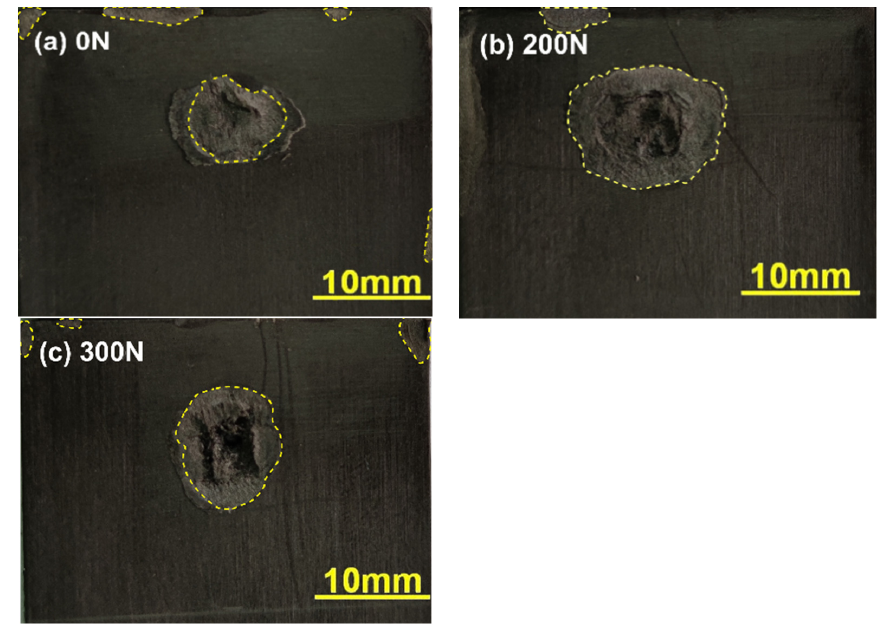
Figure 6. Effect of preload on nugget size of the joint. Experimental results show that the preload can significantly increase the nugget area, and the nugget size affects the strength of the welded joints. Levy found that the heat generation at the initial stage of UW of polymer materials is dominated by Coulomb fric- tion [26]. After the faying interface temperature reaches the glass temperature, viscoelastic dissipation becomes the main heat resource [27]. The protrusion deformation and contact area at the faying surface increase under the application of preload and welding pressure, which enhances the heat generation comes from Coulomb friction at the initial stage of